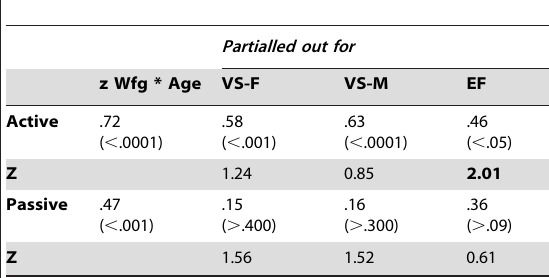
Table 3. Correlations between the wayfinding z scores and age (the p values are in parentheses) for the active and passive conditions, followed by the same correlations partialled out for each one of the neurocognitive z scores (VS- M z, VS-F z and